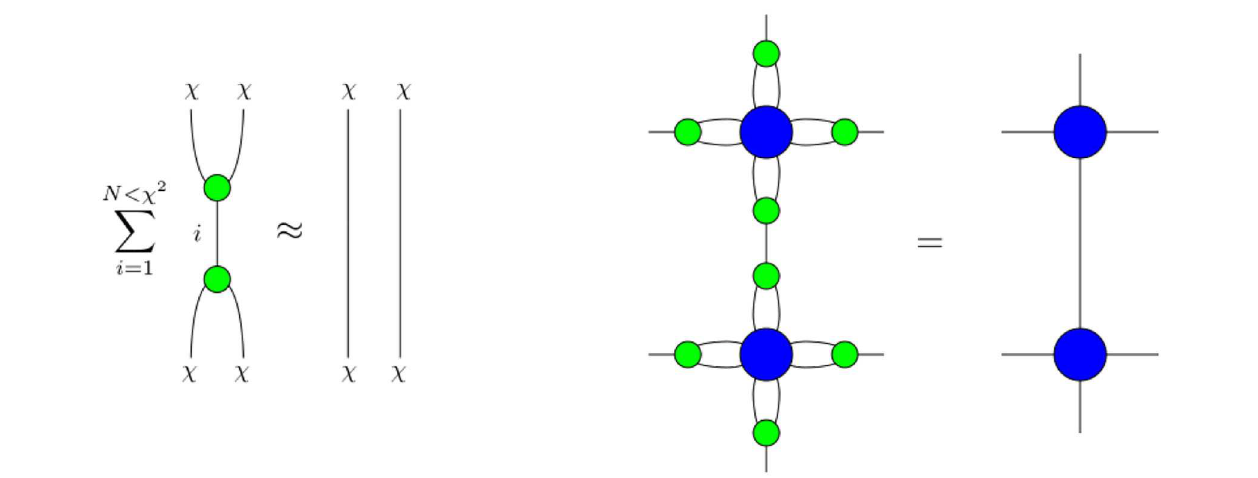
FIGURE 9 | (Left) In case the singular values for i > N are negligible, the truncated maps U † U approximate the resolution of identity well, such that inserting them in-between the pair of indices barely changes the partition function. (Right) Starting from the tensors in the middle of Figure 8 , we insert the truncated resolution of identity for each pair of edge. Then we obtain the new effective tensor by contracting the previous tensor with its respective embedding